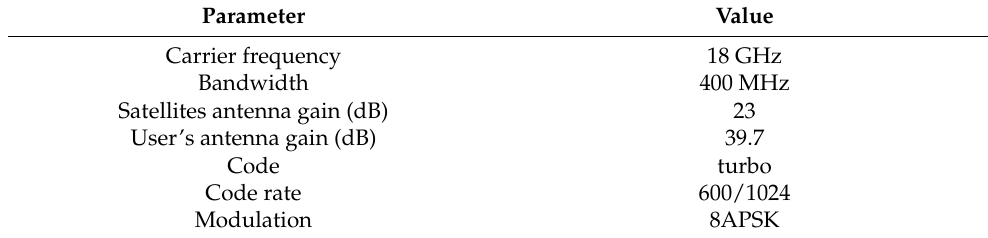
Table 1. System Parameters.